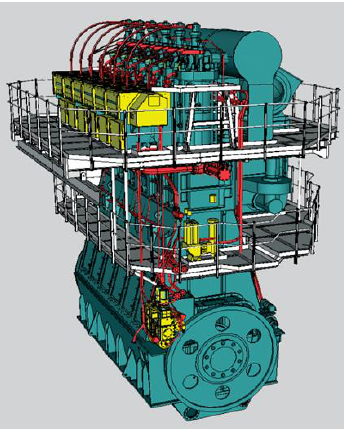
Figure 1. A model of the slow-speed two-stroke diesel engine Wärtsilä RT-flex50. Table 1. Technical data of the Wärtsilä RT-flex50 engine. Engine